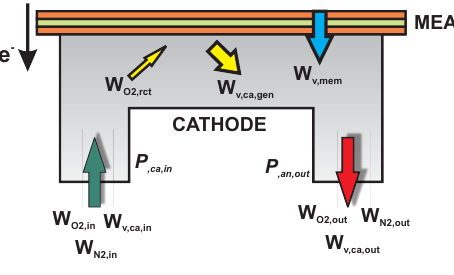
Figure 6. Mass flows modeled in